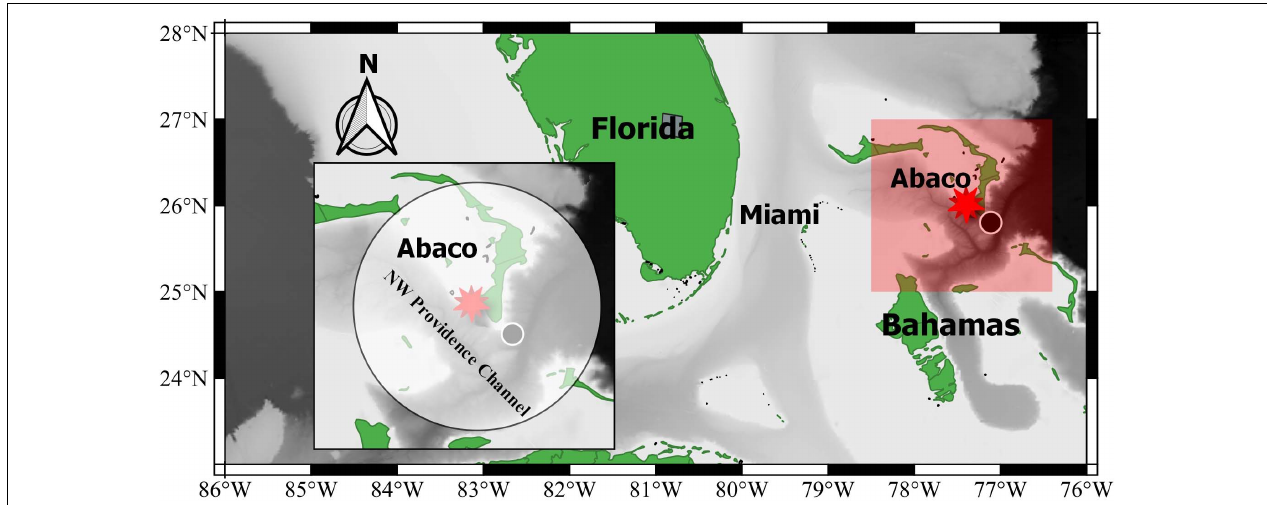
FIGURE 1 | A map of islands in the northern Bahamas, their proximity to the Florida panhandle and the study area, a circle indicating the average 93 km distance messages can be received at the Automatic Identification System (AIS) station, including locations of the AIS station ID 844 (red star) and ST500 hydrophone (black circle) off the southern end of Abaco Island. GEBCO